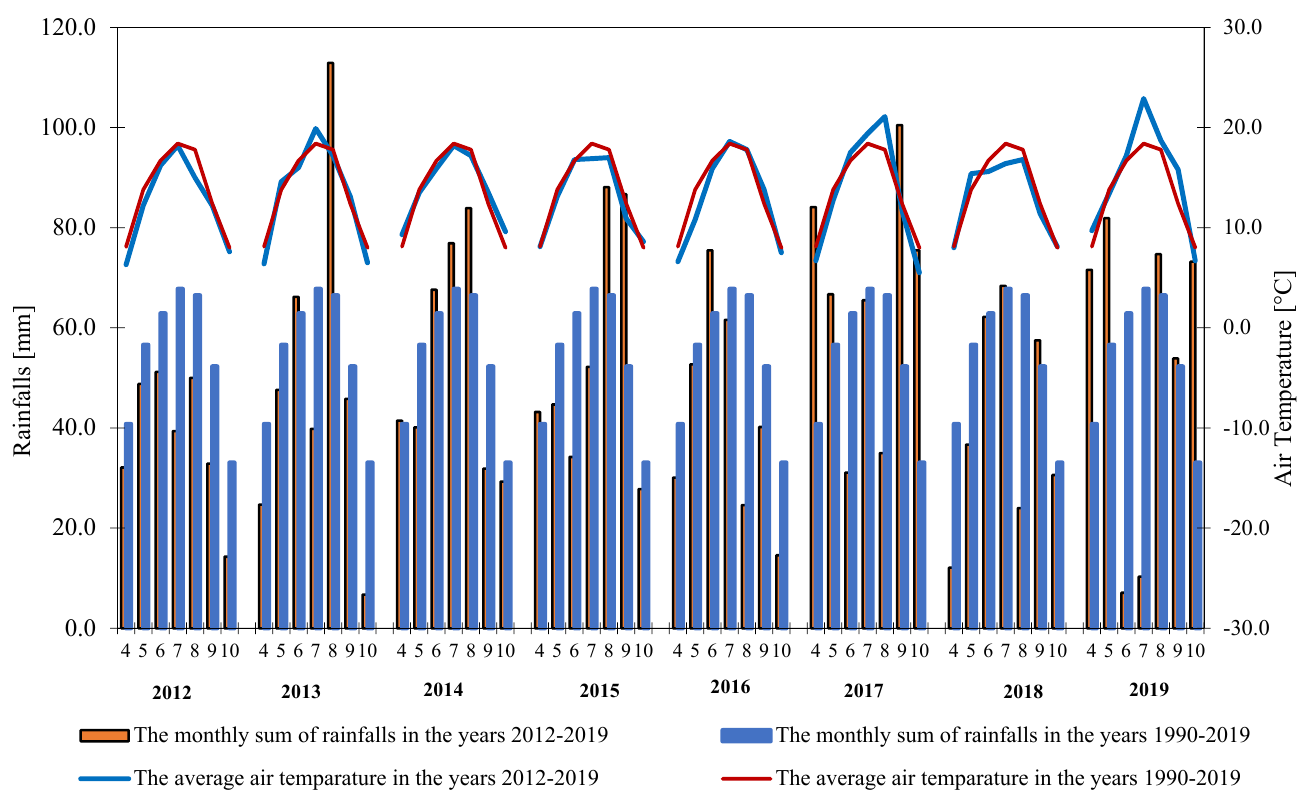
Figure 1. Rainfalls and air temperature during vegetation period in the years 2012–2019 acc. to meteorological station in Krosno.